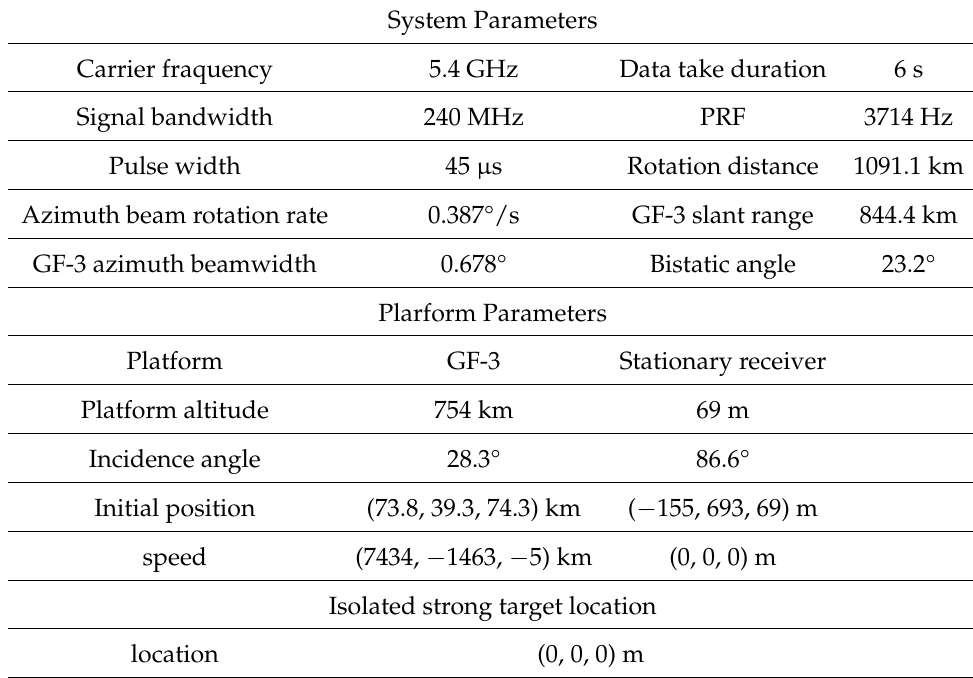
Table 4. Parameters of the equivalent experiment.